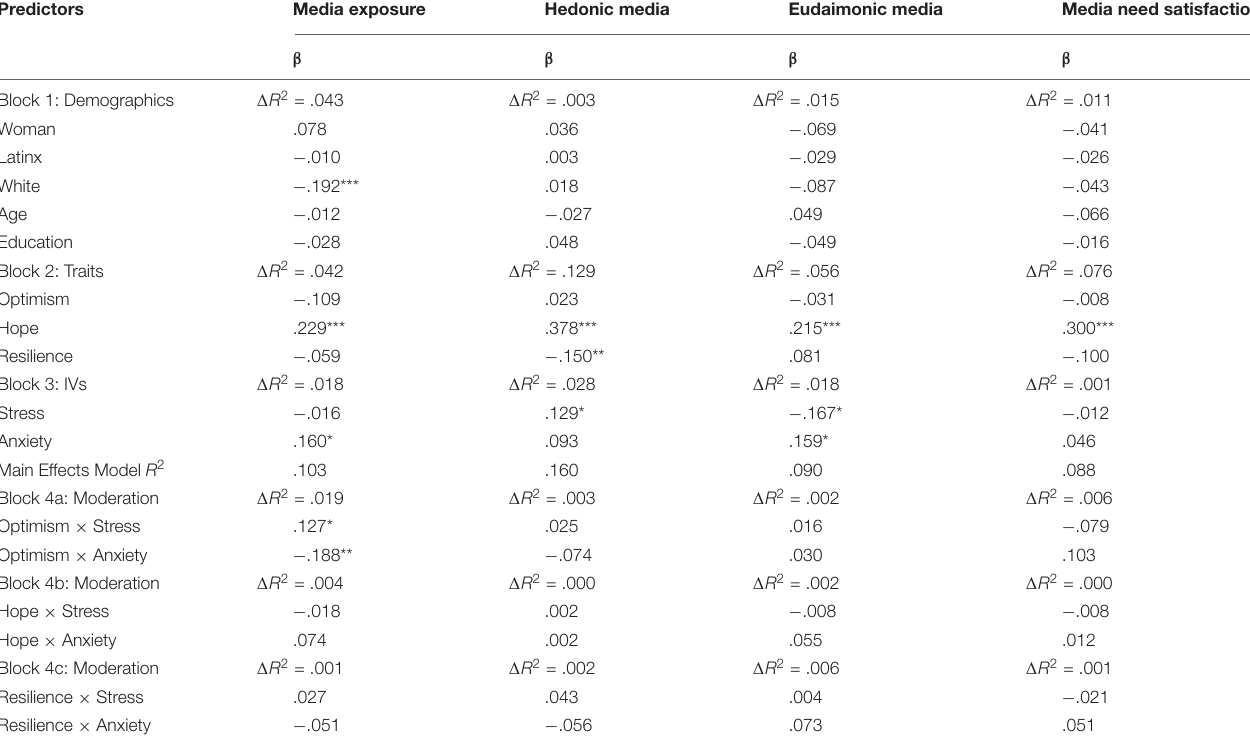
TABLE 4 | Associations of stress and anxiety with media use